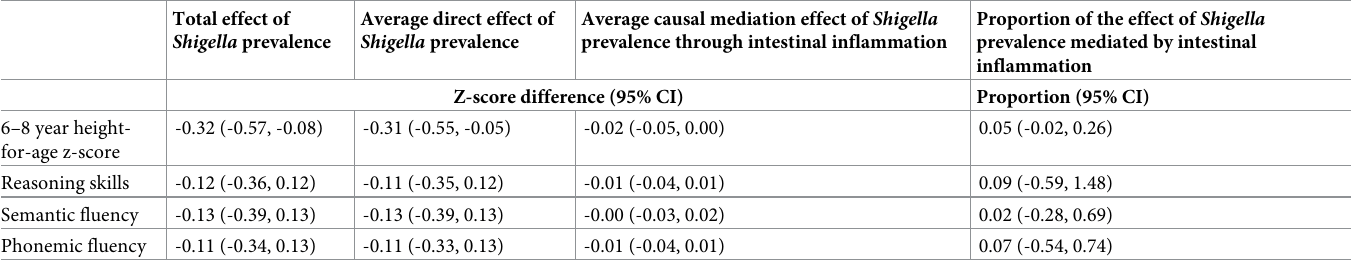
Table 2. Mediation effects to assess whether intestinal inflammation mediated the associations between Shigella prevalence and linear growth and cognitive out- comes at 6–8 years of age among 451 children in the Brazil, South Africa, and Tanzania MAL-ED